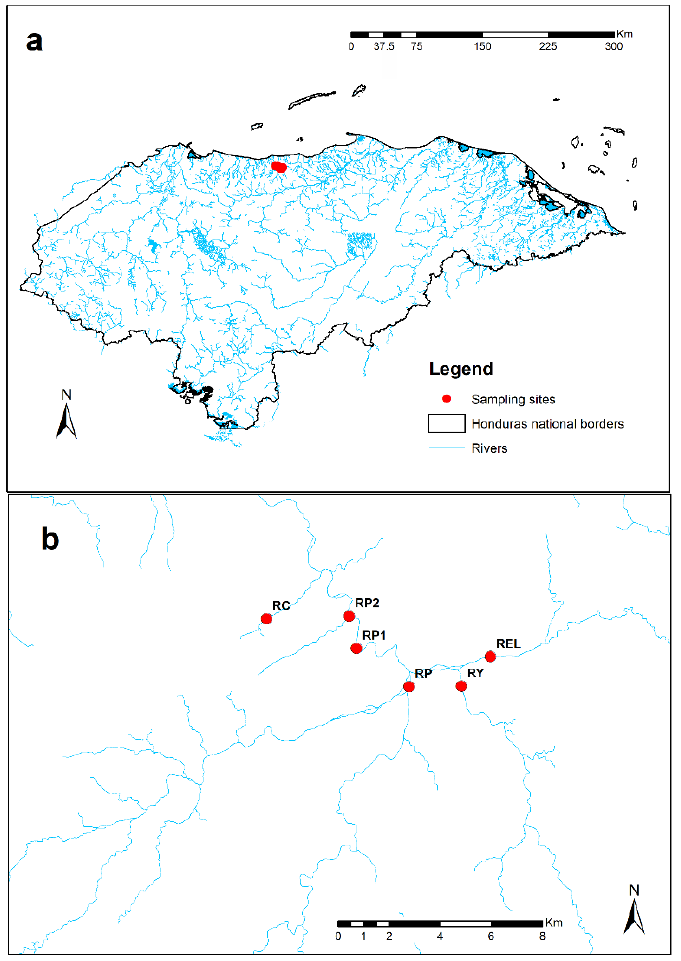
Figure 1. Study area ( a ) and geographical location of sampling sites ( b ): REP = Río El Padre, RY = Río Yaruca, RV = Río Viejo, P1 = Río Pital1, P2 = Río Pital2, RC = Río Cangrejal.